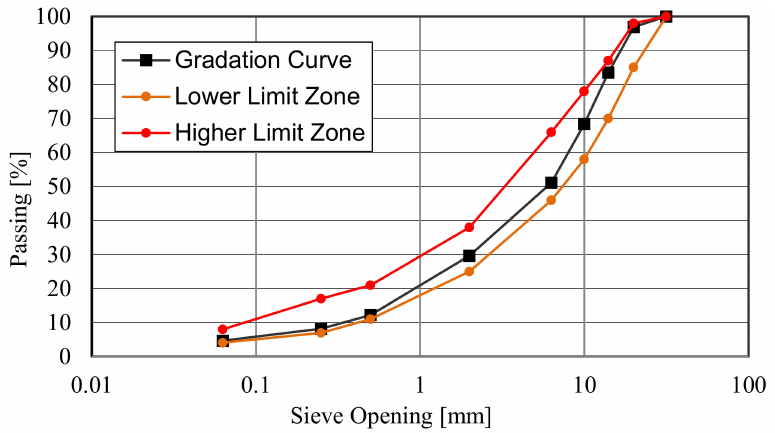
Figure 1. Gradation